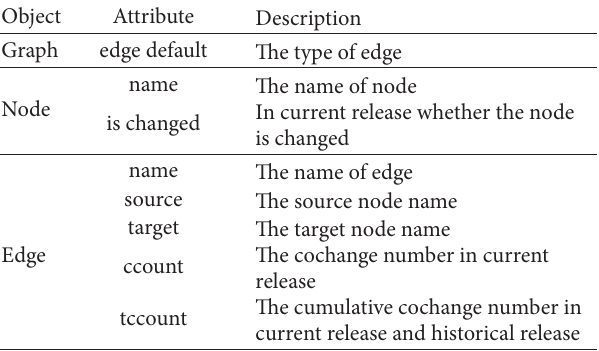
Table 2: Descriptive information for GraphML